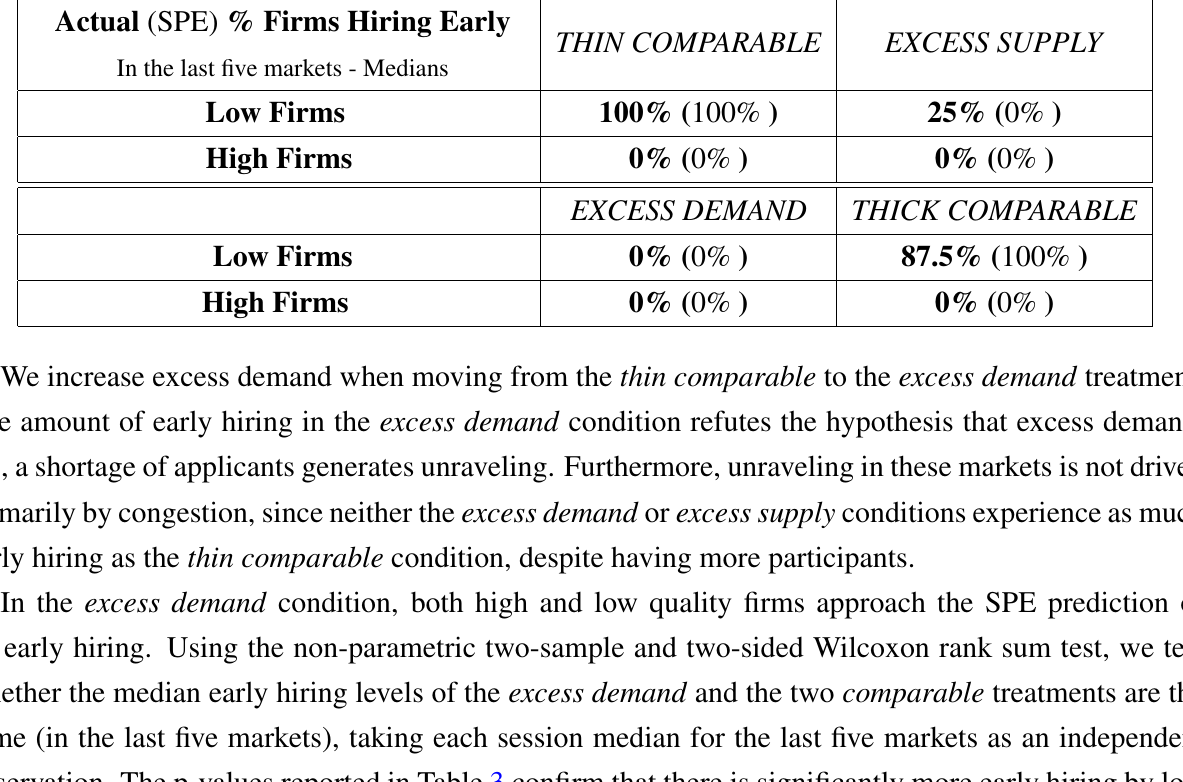
Table 2. Median percentage of firms hiring early in the last five markets, with subgame perfect equilibrium predictions in parentheses.